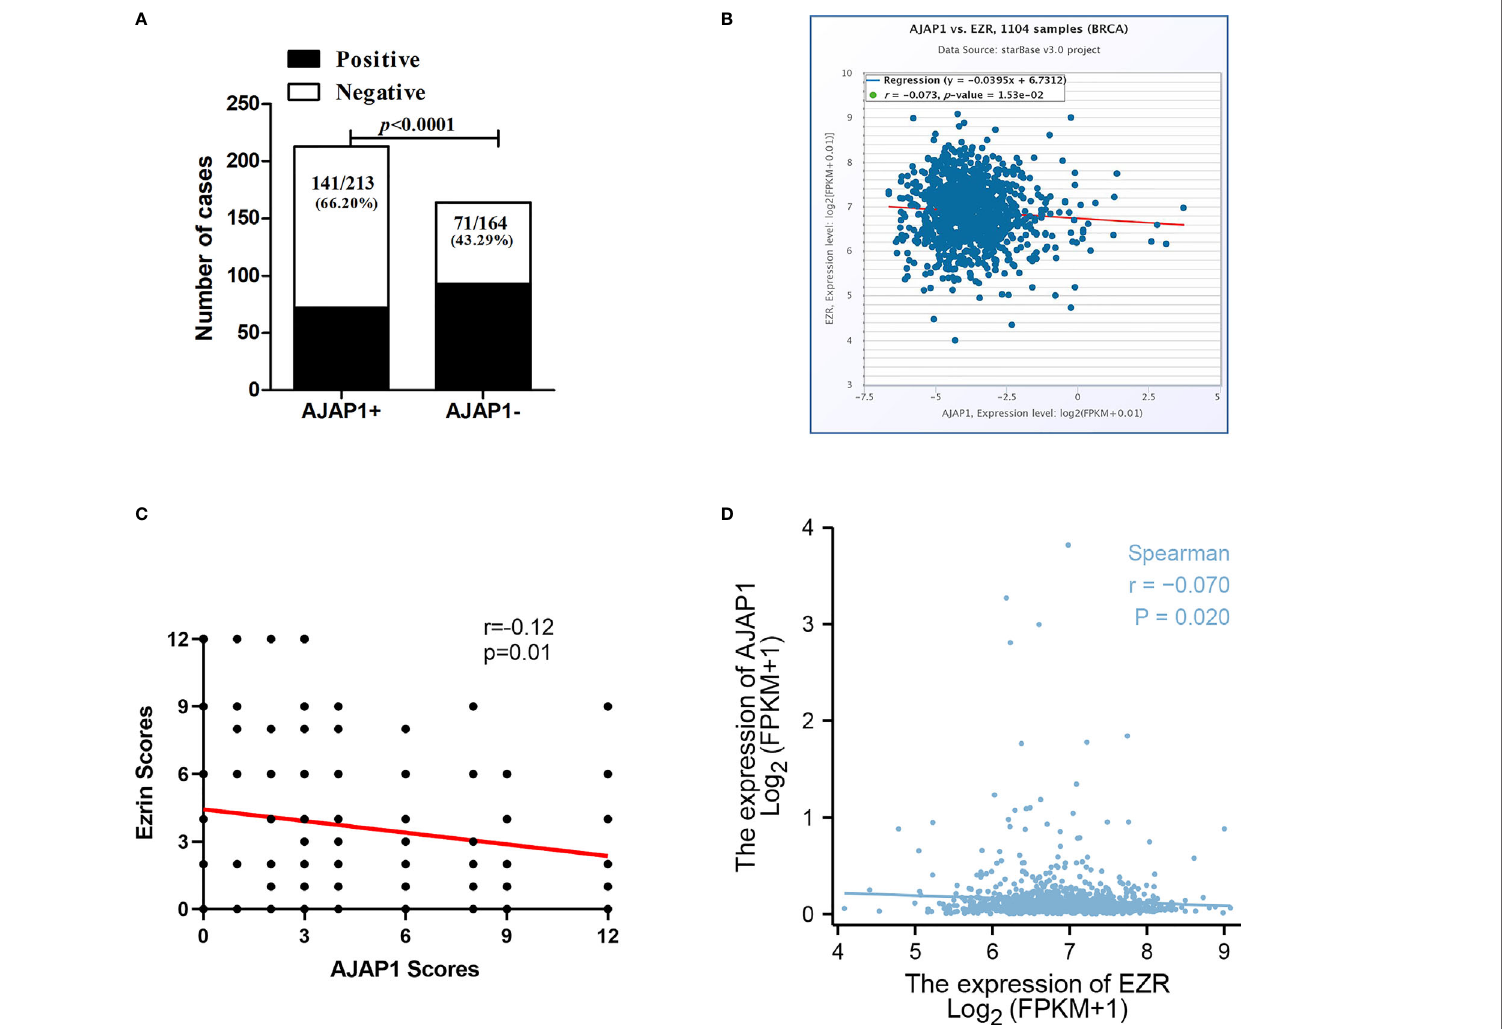
FIGURE 2 | AJAP1 expression is negatively correlated with Ezrin expression. (A) Number of cases of different Ezrin expression in AJAP1+ and AJAP1- samples. (B) Scatter plot analysis for the correlation between AJAP1 and Ezrin based on starBase v3.0. (C) Spearman test about the relationship between AJAP1 and Ezrin in 377 breast cancer cases. (D) Spearman analysis for the correlation between AJAP1 and Ezrin based on TCGA